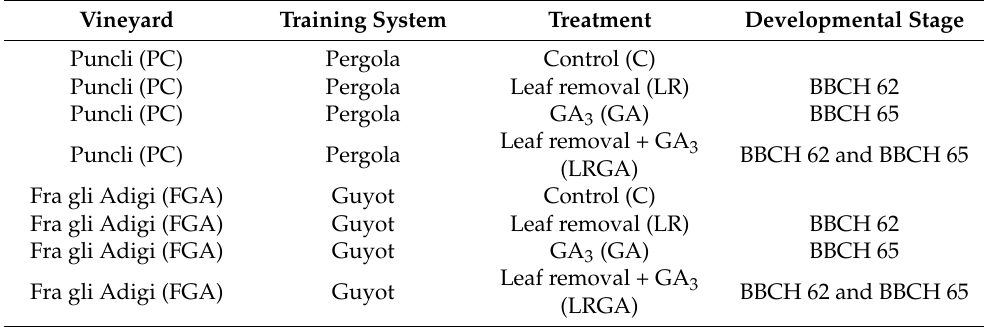
Table 1. Overview of the treatments applied in each vineyard with relative developmental stage of application and acronym for each